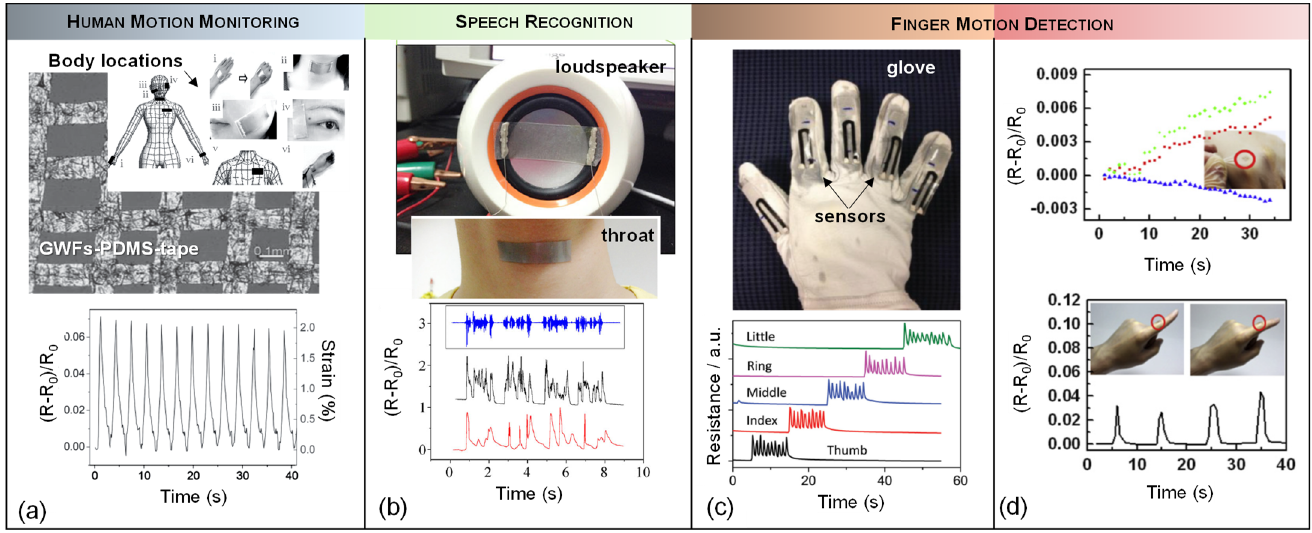
Figure 8. ( a ) Optical microscope image of graphene woven fabrics (GWFs)-PDMS-tape composite film (scale bar 0.1 mm) and the relative resistance change as a function of applied strain varying between 0% and 0.2%, “Reprinted with permission from ref. [187] . Copyright (2014) John Wiley and Sons” ( b ) Photograph of a strain sensor attached to the vibrating membrane of a loudspeaker and to a participants’ throat, where similar change in relative resistance was observed as the same sentence was played from the loudspeaker (black curve) and read out loud (red curve) “Reprinted with permission from ref. [189] . Copyright (2015) Springer Nature” ( c ) Application of graphene nanopaper-based sensors on a glove is imaged and the transitions between the corresponding resistance changes of the strain sensor by the motion of each of the fingers, “Reprinted with permission from ref. [173] . Copyright (2013) John Wiley and Sons” ( d ) Observation of relative resistance changes in the strain sensor on a glove when the finger bends or unbends and using a rosette gauge on the glove to detect the direction of principal strain by applying stretch gently “Reprinted with permission from ref. [143] . Copyright (2013) Elsevier”.